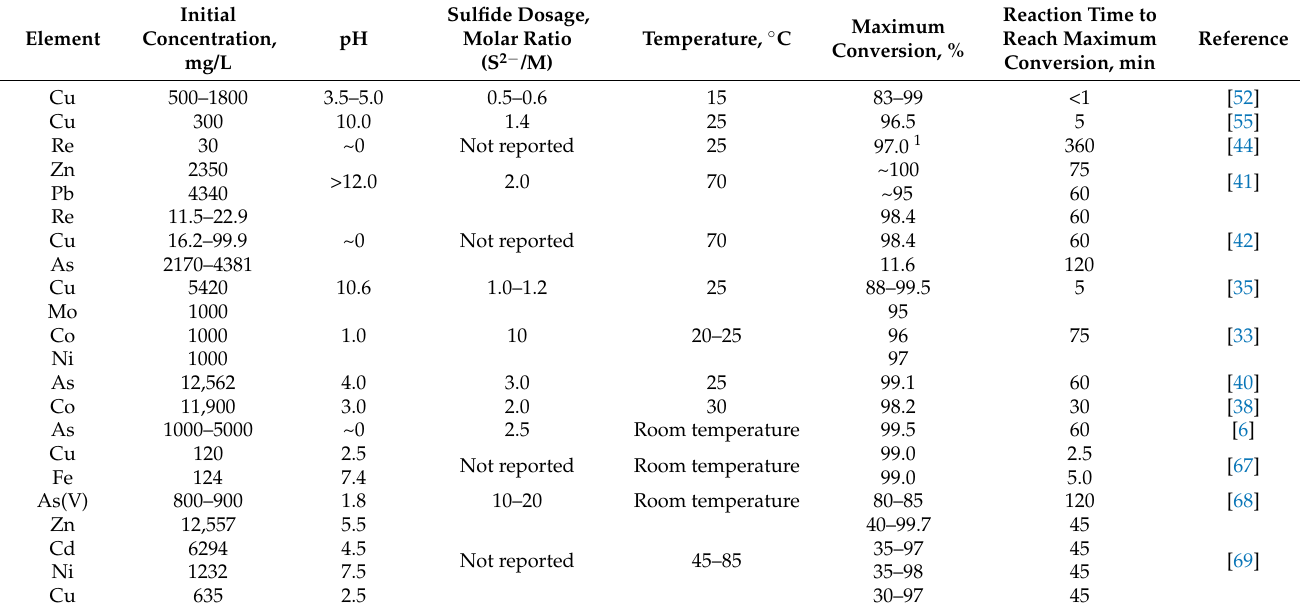
Table 3. Summary of operational conditions and results of maximum conversion and reaction